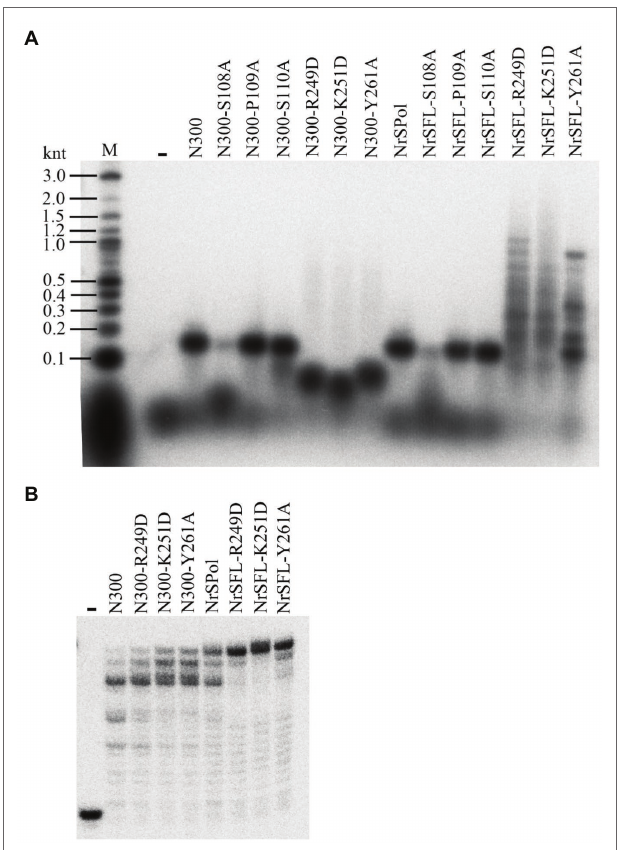
FIGURE 3 | Enhanced primer extension activities of mutants of full-length NrSPol. (A) Primer extension assays with 5 nM primed-M13 ssDNA (annealed with 32 P-labeled M13 primer, 5 ' -CCCAGTCACGACGTT-3 ' ) substrate. The reactions were incubated for 30 min at 50 ° C and the products were separated on a 2% alkaline agarose gel. Data in the Figure A are representative of two independent experiments. (B) Primer extension assays with 32 P-labeled 16/36-mer primer/template duplex substrate. The reactions were incubated for 6 min at 50 ° C, and the products were separated on a 7 M urea-10%